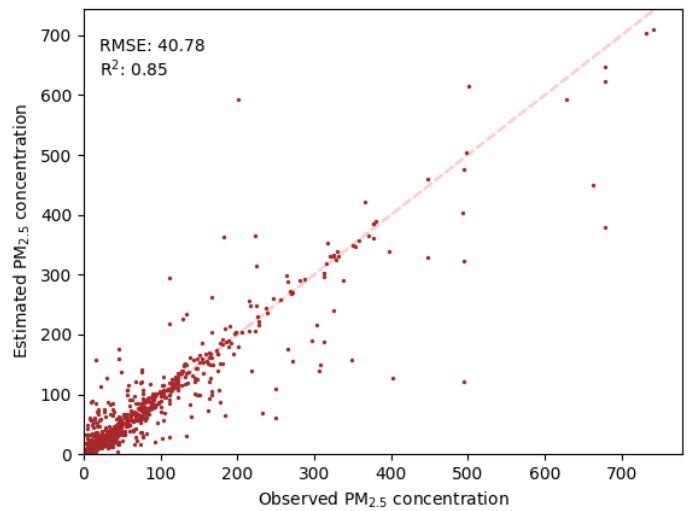
Figure 6. Correlation between PM 2.5 concentrations measured at ground-based monitoring stations and PM 2.5 concentrations estimated by the MIFNN model. The red dashed line is the 1:1